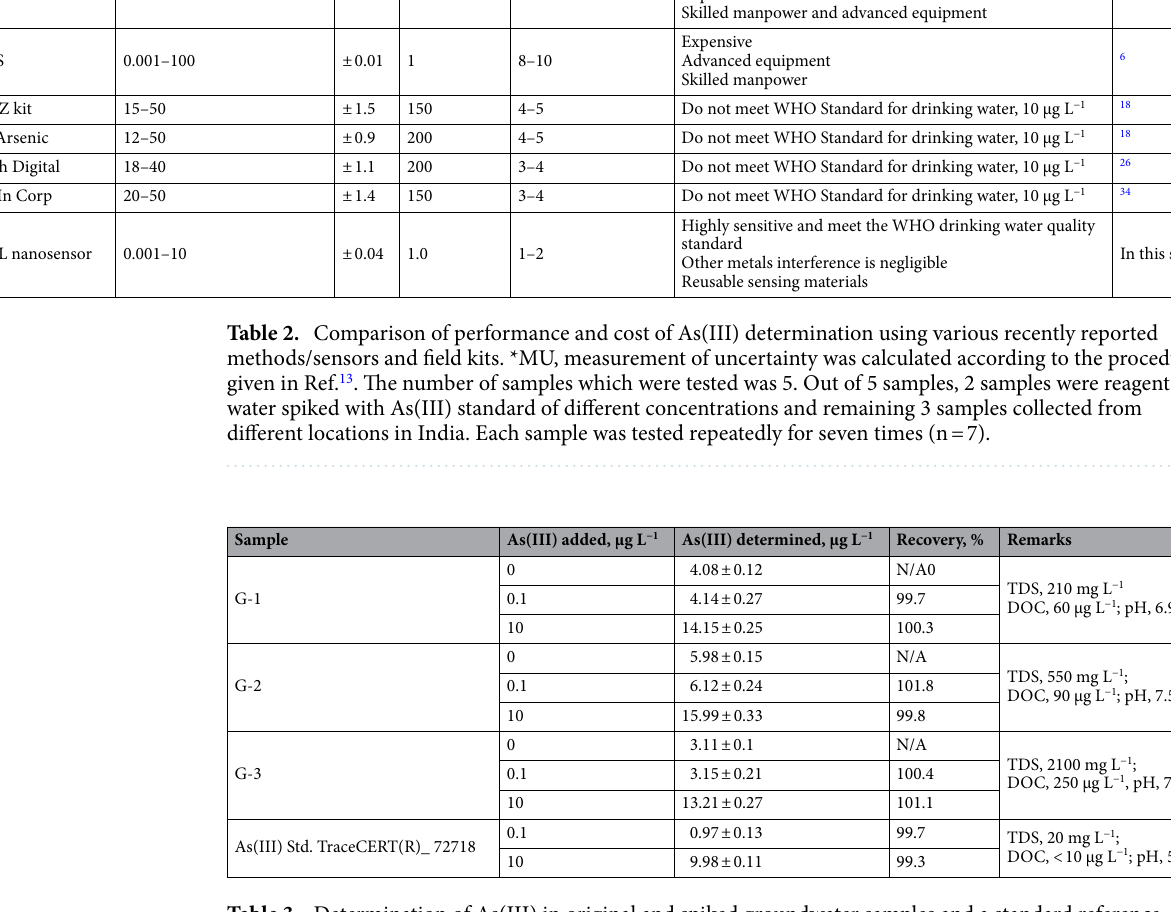
Table 3. Determination of As(III) in original and spiked groundwater samples and a standard reference material (TraceCERT®-71718 with the concentration of 10 mg L −1 0using rGO–FL nanoparticle based fluorescence sensor. G-1 Groundwater sample was collected from the rural area near Nagpur, Maharashtra, India, G-2 the groundwater sample was collected from urban area near Nagpur, Maharashtra, India, G-3 the sample was collected near coastal area at Bhadbhut, Gujarat, India, TDS total dissolved solids, DOC dissolved organic